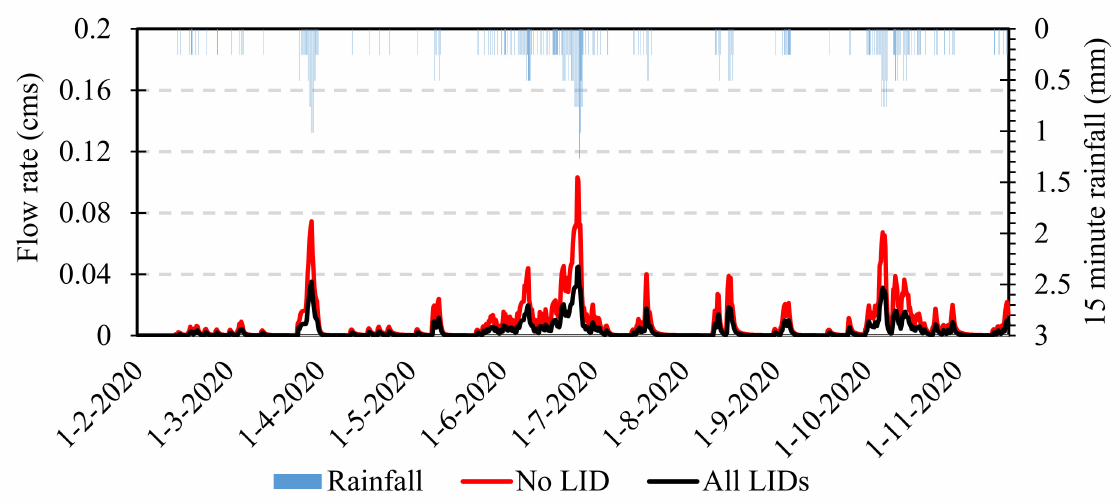
Figure 10. Comparison of simulated flow rates (cfs) at the drainage outlet with and without considering the existing LIDs in the stormwater system.